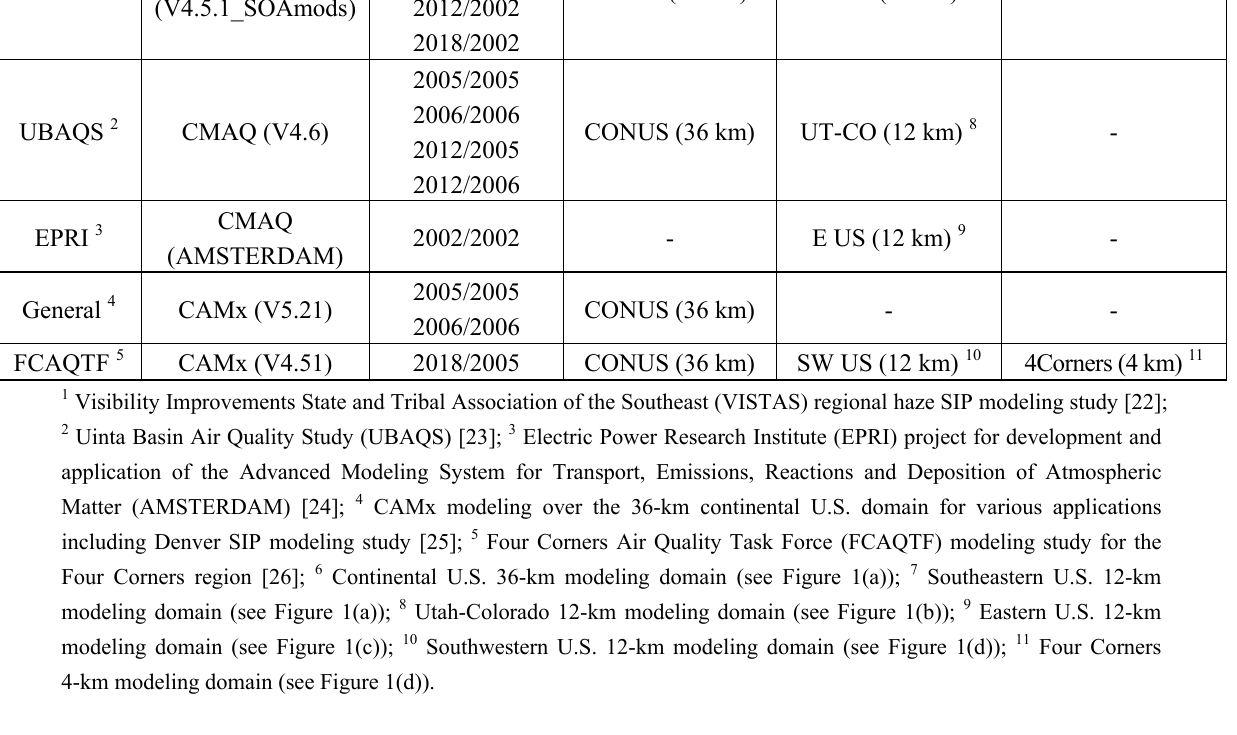
Figure 1. Modeling domains for ( a ) the Visibility Improvements State and Tribal Association of the Southeast (VISTAS) regional haze State Implementation Plan (SIP) modeling study; ( b ) the Uinta Basin Air Quality Study (UBAQS) modeling study; ( c ) the Electric Power Research Institute (EPRI) modeling study; and ( d ) the Four Corners Air Quality Task Force (FCAQTF) modeling